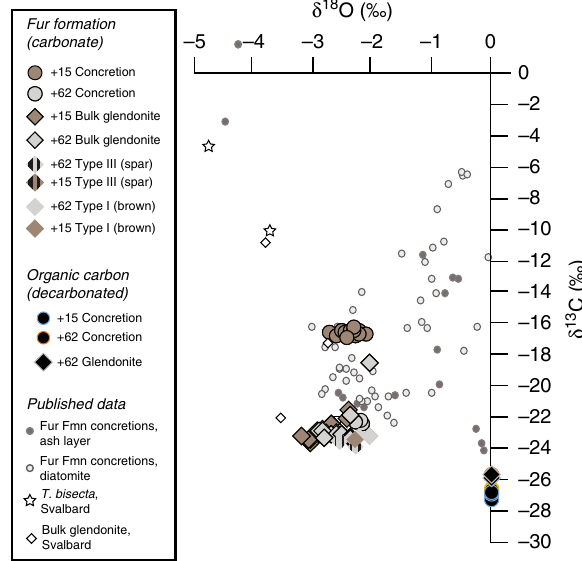
Fig. 4 Glendonite and concretion stable isotope data. Plotted stable isotope data for + 15 and + 60 – 62 horizons in the Eocene Fur Formation glendonite and concretions, along with δ 13 C data for organic matter from decarbonated glendonites and concretions. For comparison, published stable isotope data for concretions of the Fur Formation and glendonites from the early Eocene succession on Svalbard (Basilika Fmn) are also shown 4,5